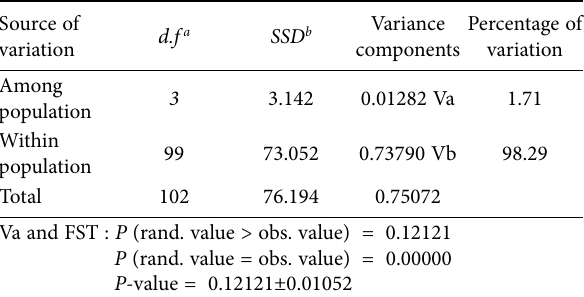
Table 4 Analysis of molecular variance of ISSR for 104 isolates of Fusarium culmorum from four Tunisian